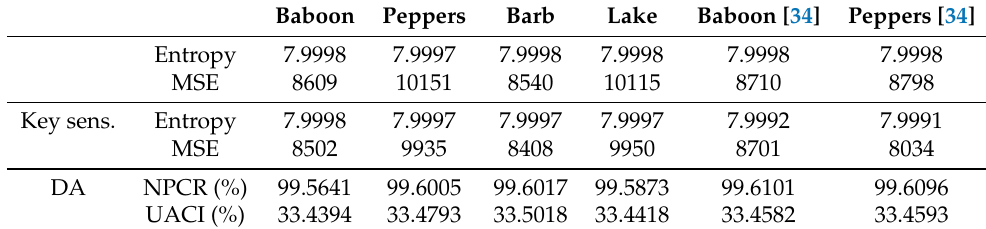
Table 3. Performance summary compared to a previous work.